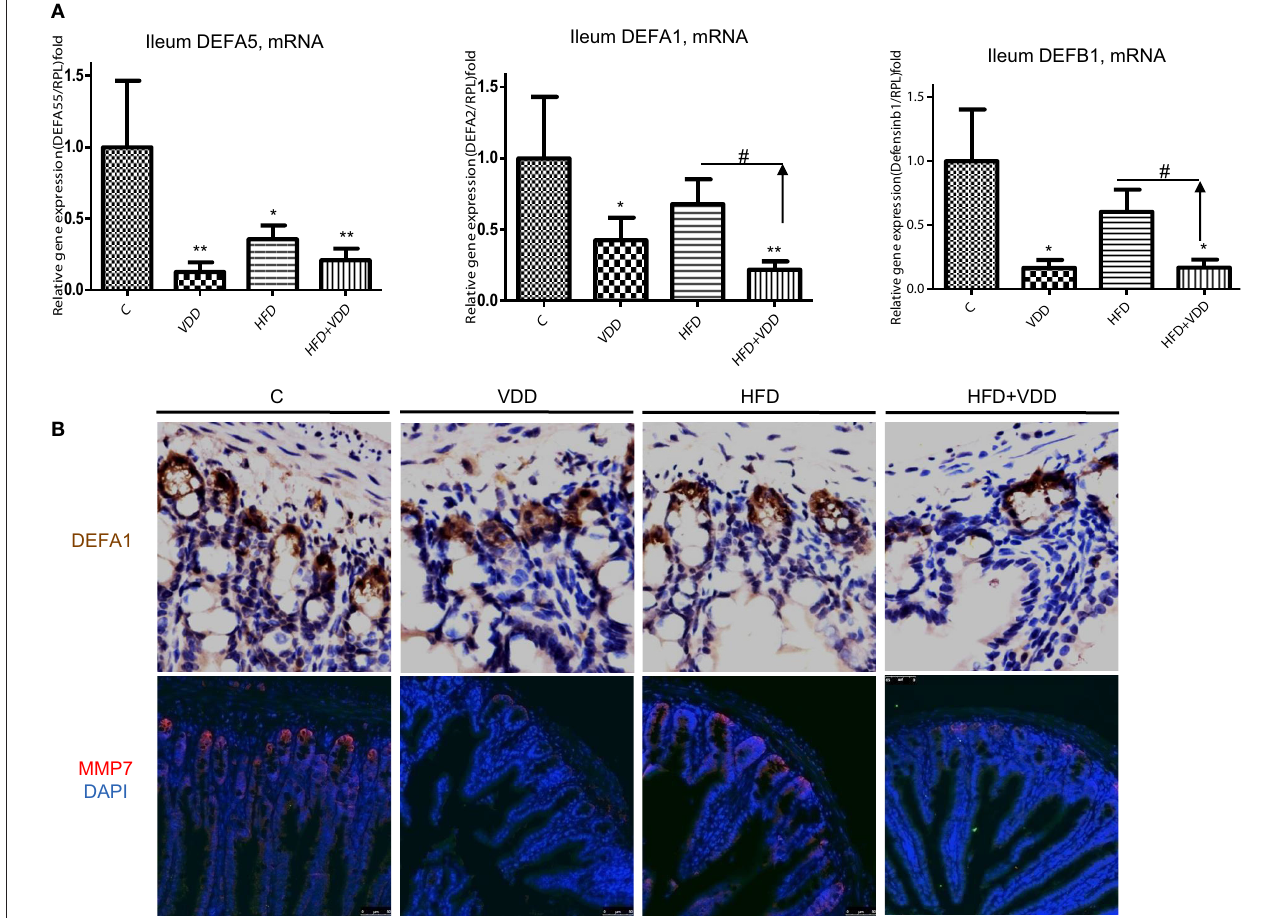
FIGURE 4 | Vitamin D signaling maintains the steady expression of Paneth cell defensins and their converting enzyme, MMP7. (A) Expression of defensins in the ileum by the mice under the four feeding conditions was determined by RT-qPCR analysis. (B) Immunohistochemical staining of the ileal region for DEFA1, and immunofluorescent staining for MMP7 in the crypts of Lieberkühn. Data ( n = 4–10 mice/group for each measurement) are presented as mean ± standard error. Comparison was conducted by t -test between the experimental groups with the control, and * P < 0.05, ** P < 0.01. # indicates the impact of vitamin